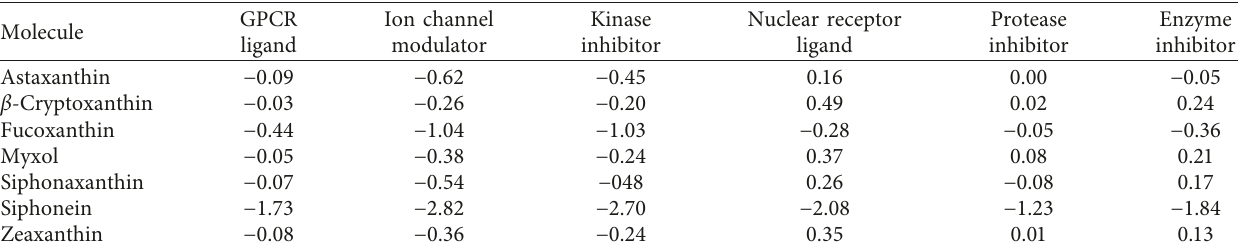
Table 15: Bioactivity scores of the seven carotenoid pigments calculated on the basis of GPCR ligand, ion channel modulator, nuclear receptor ligand, kinase inhibitor, protease inhibitor, and enzyme inhibitor interactions. GPCR Ion channel Kinase Protease Enzyme Molecule ligand modulator inhibitor ligand inhibitor inhibitor Astaxanthin β -Cryptoxanthin Fucoxanthin − 0.44 Myxol − 0.05 Siphonaxanthin